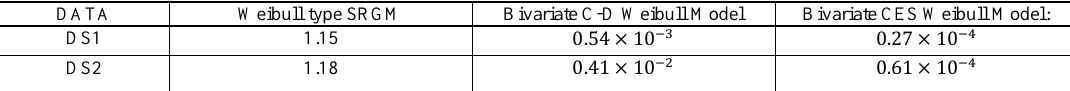
Table 3. The result of goodness-of-fit comparison based on